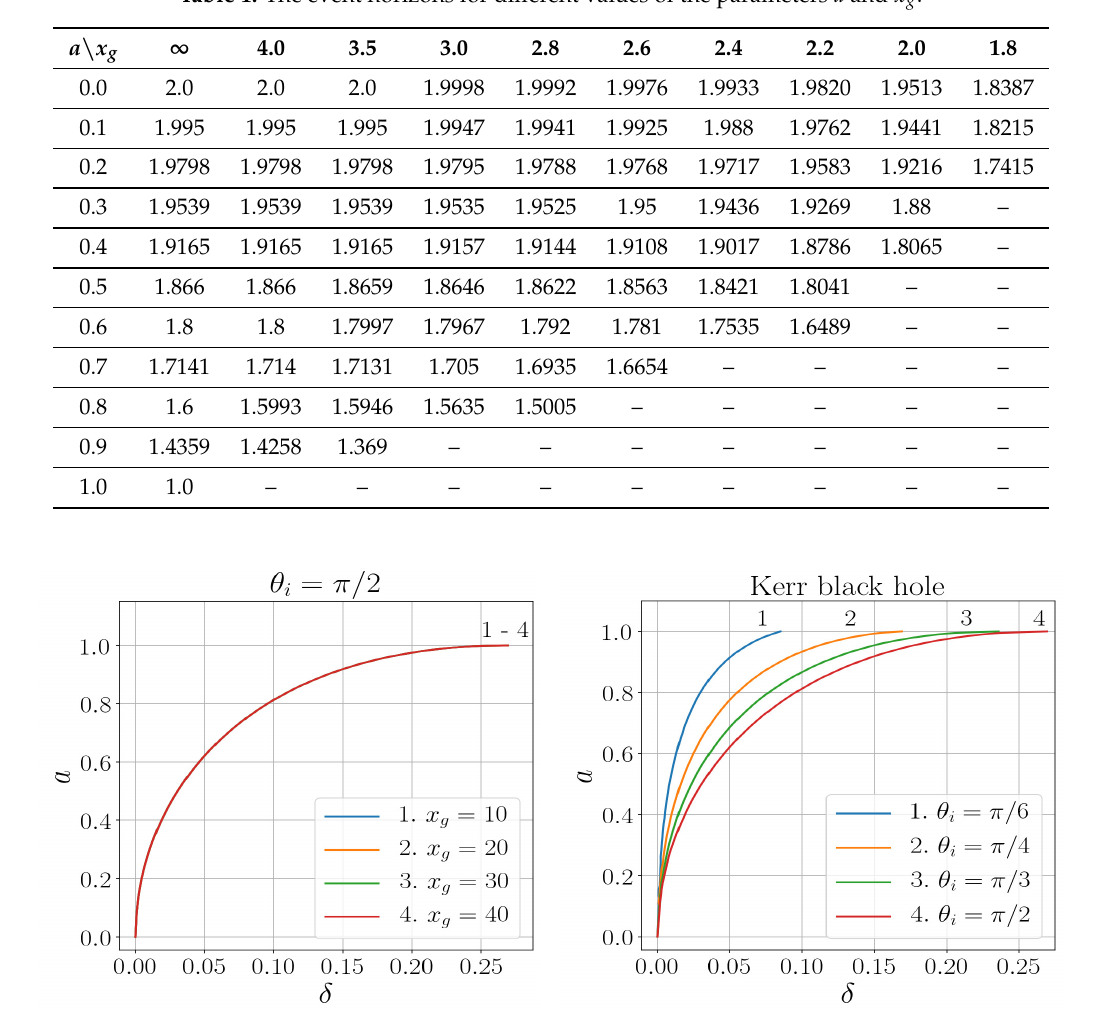
Table 1. The event horizons for different values of the parameters a and x g .